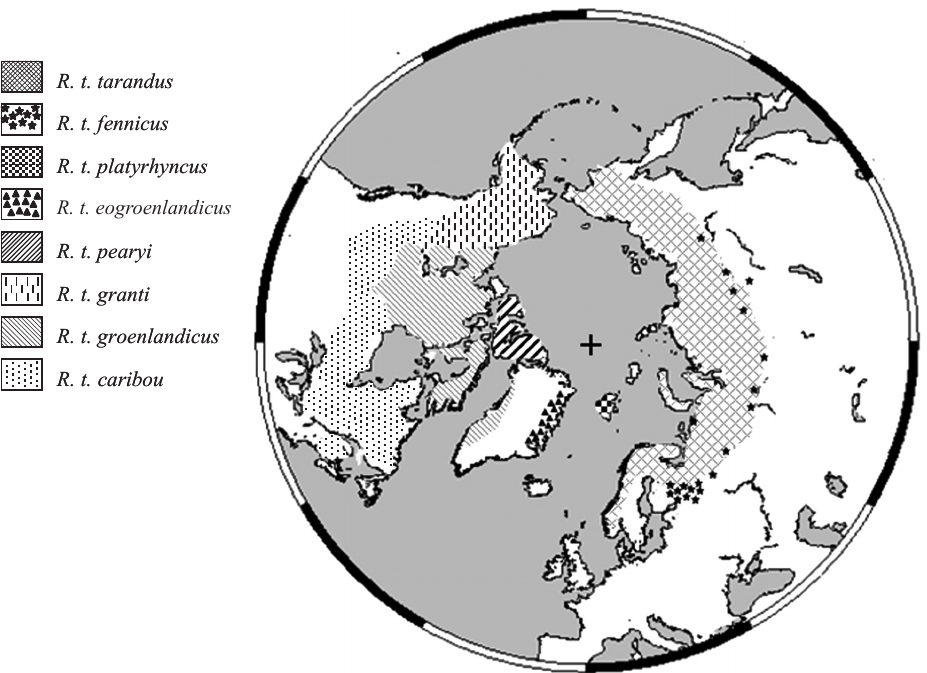
Fig. 1. Geographic distribution of the different subspecies of reindeer. Although additional subspecies have been suggested, these eight constitute the conventional taxonomic classification of the